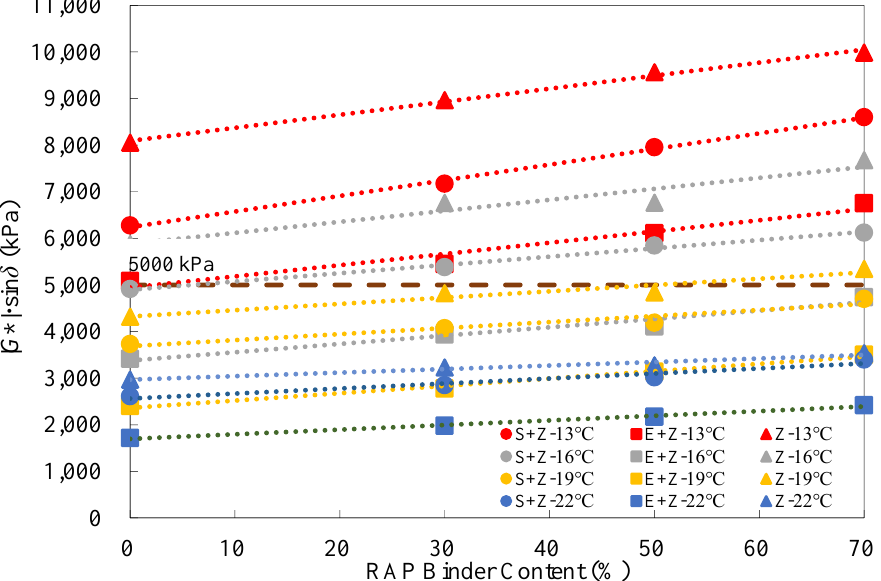
Figure 10. Fatigue parameter test results of the warm-mix recycled binders at different RAP binder contents and testing temperatures under the long-term aged condition.